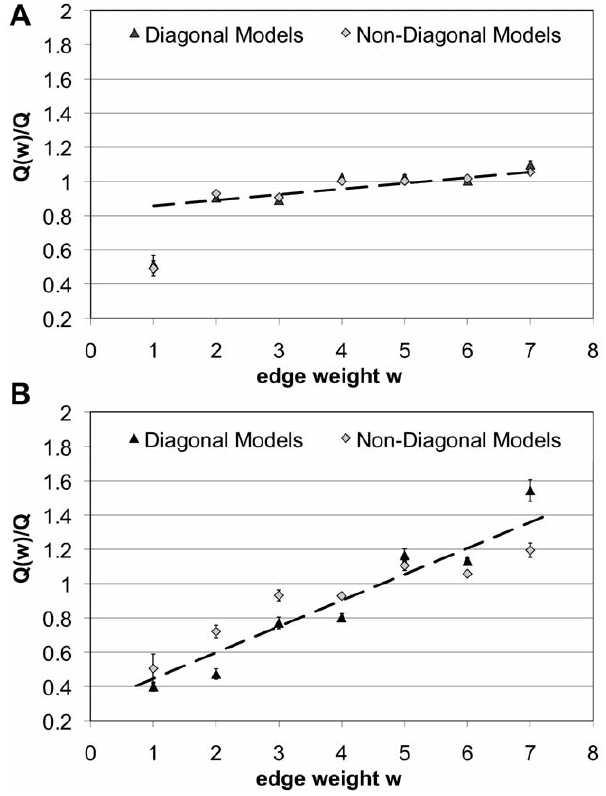
Figure 8. Fit-score as a function of link weight. Averaged over q ~ 5 to q ~ 25 , q ~ 50 and q ~ 100 , we show the fit scores Q B ( w ) and Q N ( w ) for each link type individually. Scores are normalized to the fit score obtained on the full data set from which also the assignment of nodes into classes and the image graphs are taken. A Actual HPRD data. Standard deviations are smaller than symbol sizes. B Randomized version of HPRD. As expected, we find the score increasing with weight. In the real data, increase of score with weight is slower, indicating a high correlation between the scores obtained for links representing different experimental techniques. As an exception, interactions with weight one, i.e. representing to Y2H -data only, show a significantly lower score than expected. See text for